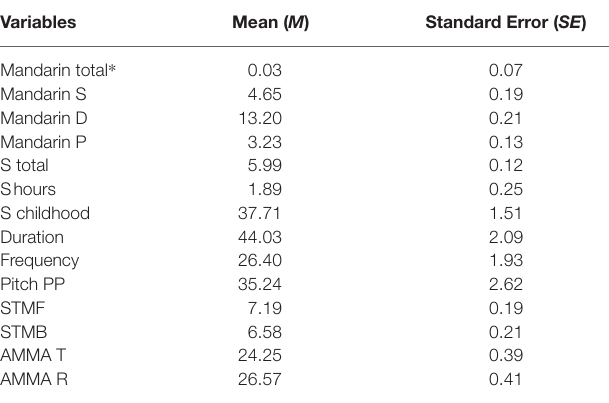
TABLE 2 | Descriptive statistics provide the descriptives of the variables under consideration. Variables